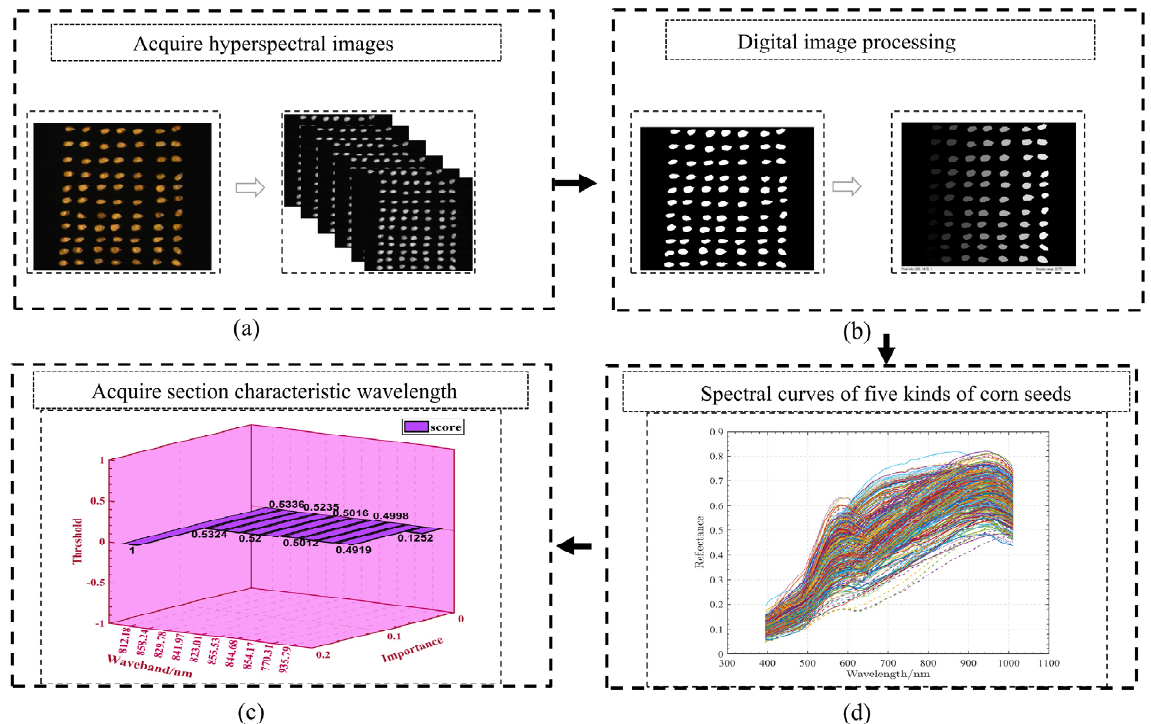
Figure 2. Hyperspectral image processing and curves.